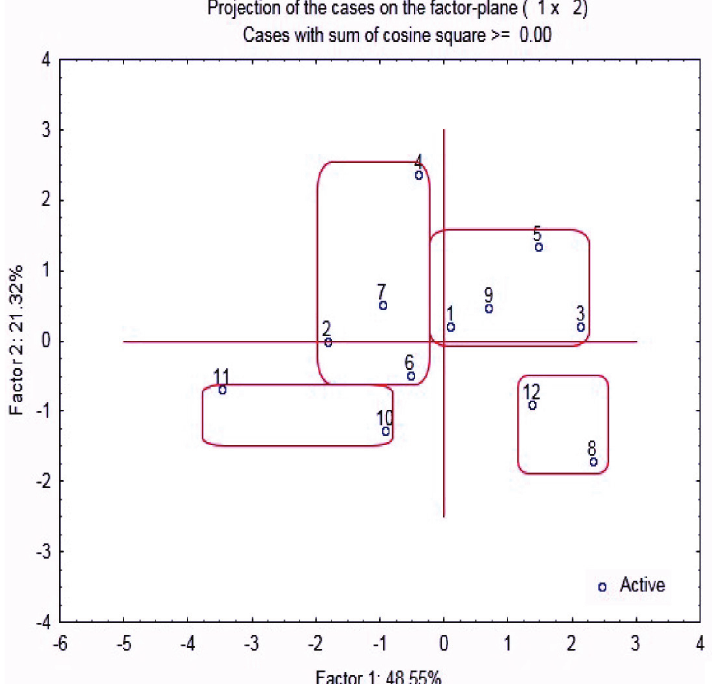
Figure 2. PC1–PC2 scores plot obtained using the TPC, TAC, AA, IC50, Pro-ox and Pro-Antidex